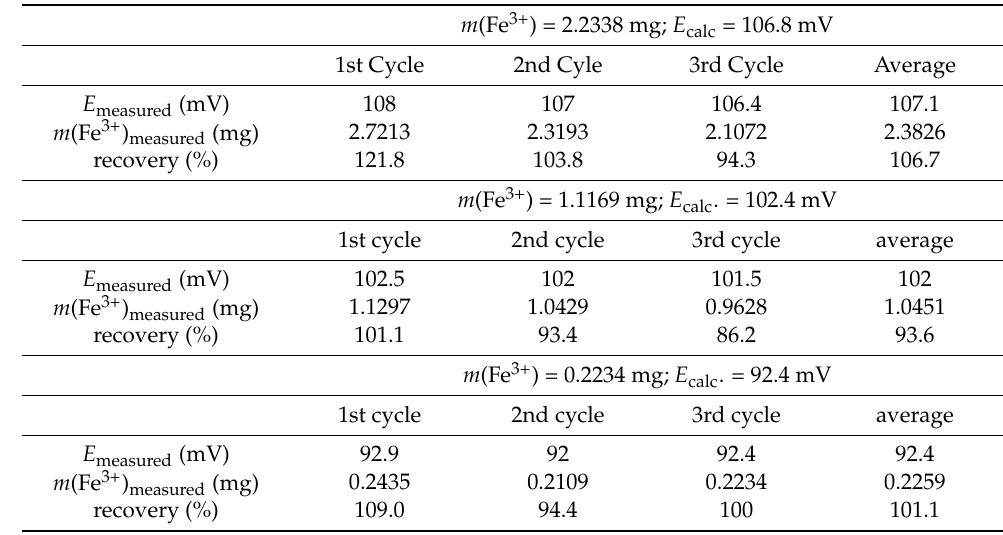
Figure 16. Potential change dependence of pFe evaluated for MN1 membrane in standard solution. Table 7. Test results for MN1 in standard solution for m (Fe 3+ ) = 2.238 mg, m (Fe 3+ ) = 1.1169 mg and m (Fe 3+ ) = 0.2234 mg.